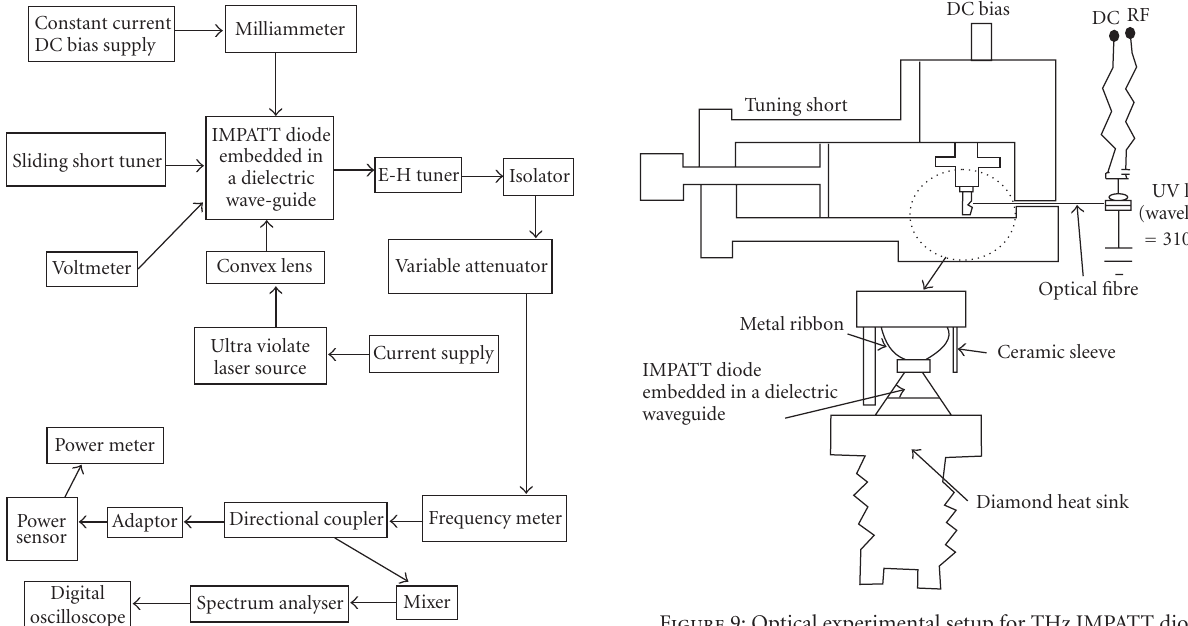
Figure 9: Optical experimental setup for THz IMPATT